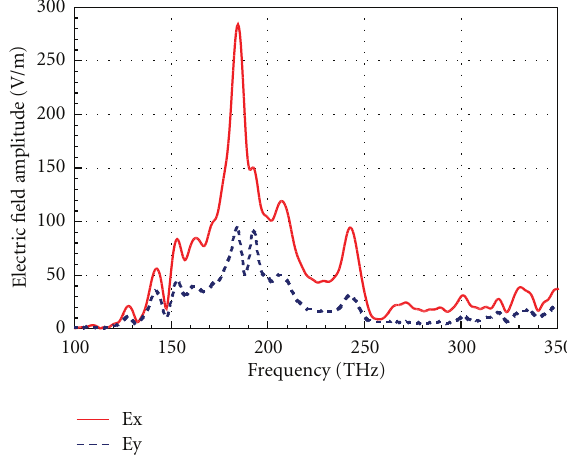
Figure 3: Electric field component along x - and y -directions at the feed gap location of Archimedean spiral antenna for x -polarized unity strength plane wave